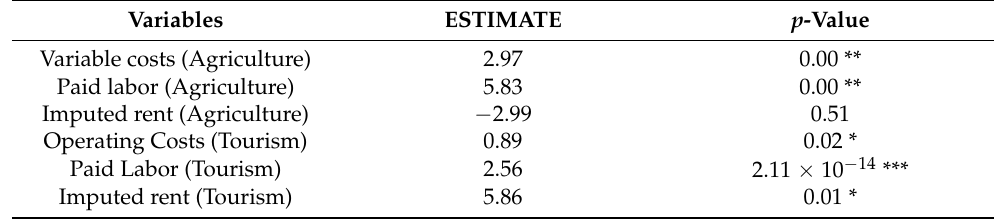
Table 7. Bootstrap Regression